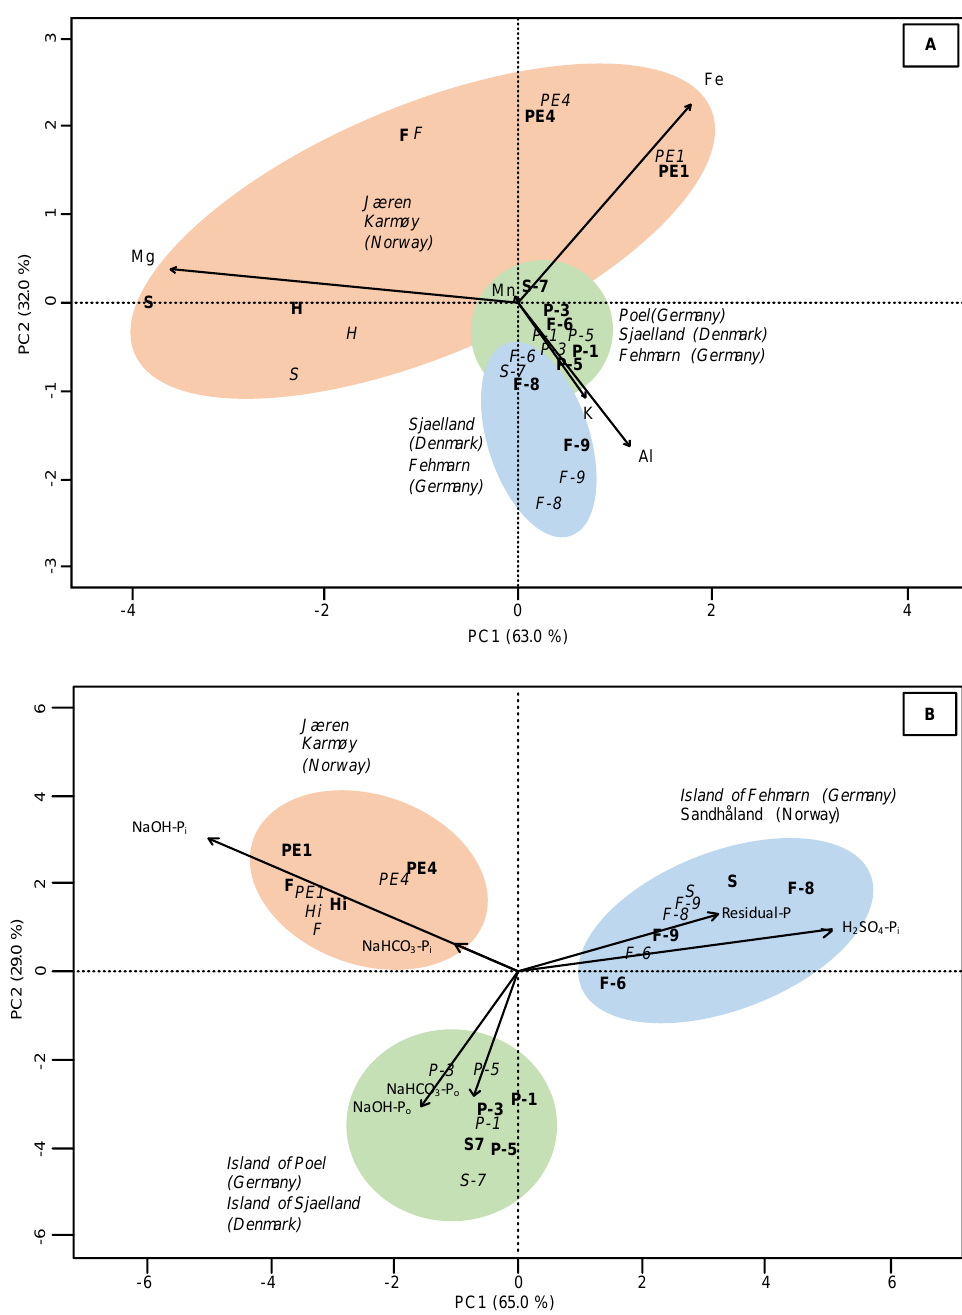
Figure 2. Principal component analysis (PCA) score plot of the proportions of the elements of 12 Northern European soil profiles (F, H, S, PE1, PE4, S-7, F-6, F-8, F-9, P-1, P-3, P-5) (data in Table 1) ( A ) and of the proportions of the P species from the SF of 6 Northern European soil profiles (F, S, PE1, S-7, F-6, P-3) (data in Table 2) ( B ). The upper horizons are represented in italics and underlying horizons as bold symbols. Differently colored areas represent clusters of soils according to their element or P composition; arrows indicate the presence of specific elements or P-compounds in the soil samples (arrow direction shows direction of elements or P-compound enrichment; arrow length shows intensity of enrichment).